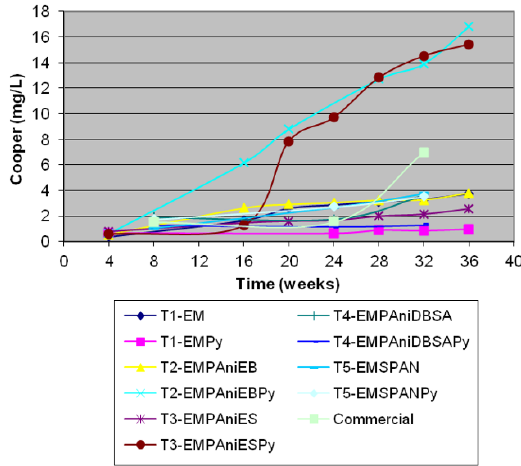
Figure 8. Total concentration of Cu released in the leaching